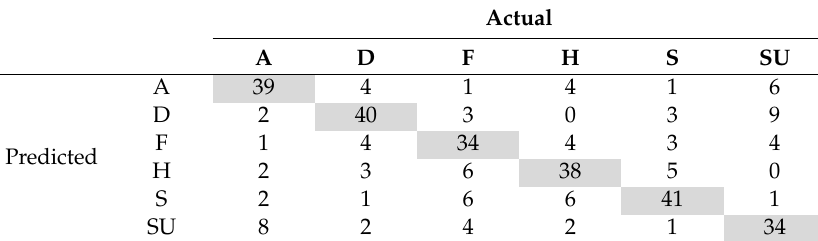
Table 6. Confusion matrix of the NC group using the H 3 feature in KNN